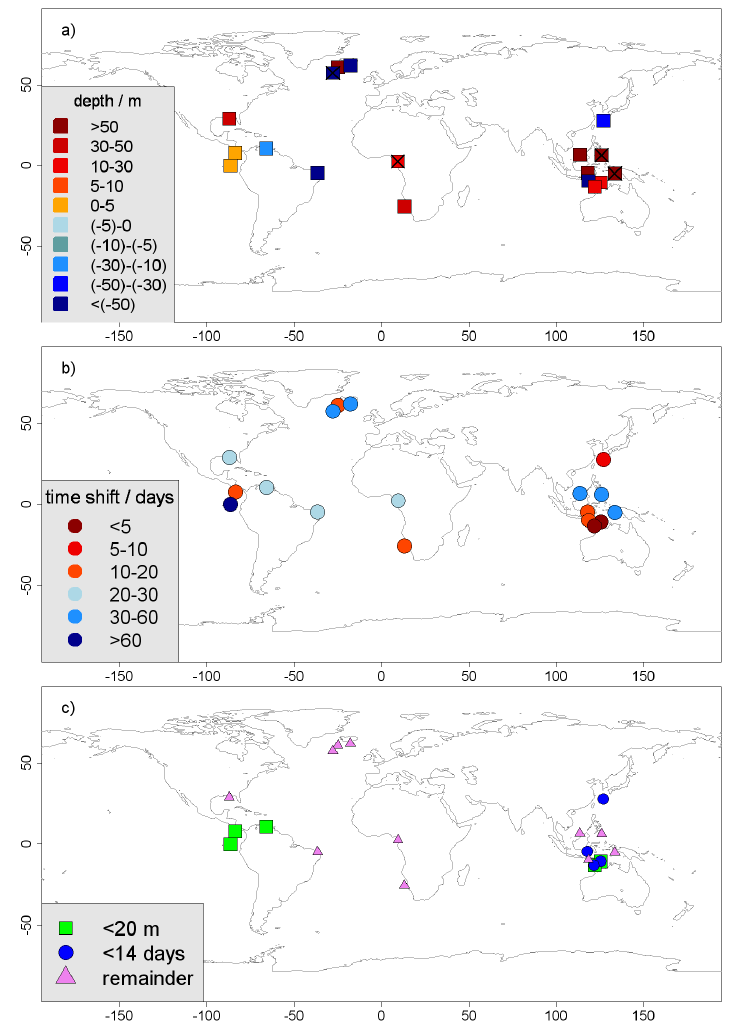
Fig. 13. (a) , (b) , and (c) as Fig. 12, but for Mg/Ca-based temperature